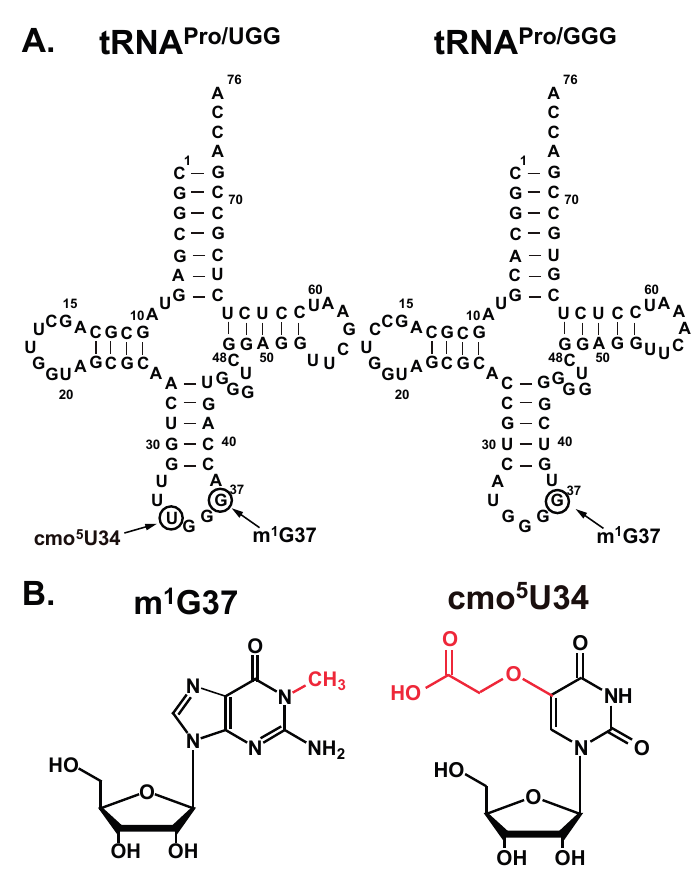
Figure 1. Sequence and cloverleaf structure of the UGG and GGG isoacceptors of E. coli tRNA Pro . ( A ) The sequence and nucleotide numbering is shown in the standard tRNA framework [19]. The nucleotides subject to post-transcriptional modifications from U34 to cmo 5 U34 and from G37 to m 1 G37 are indicated by circles; and ( B ) The chemical structure of cmo 5 U and m 1 G, showing the modification in